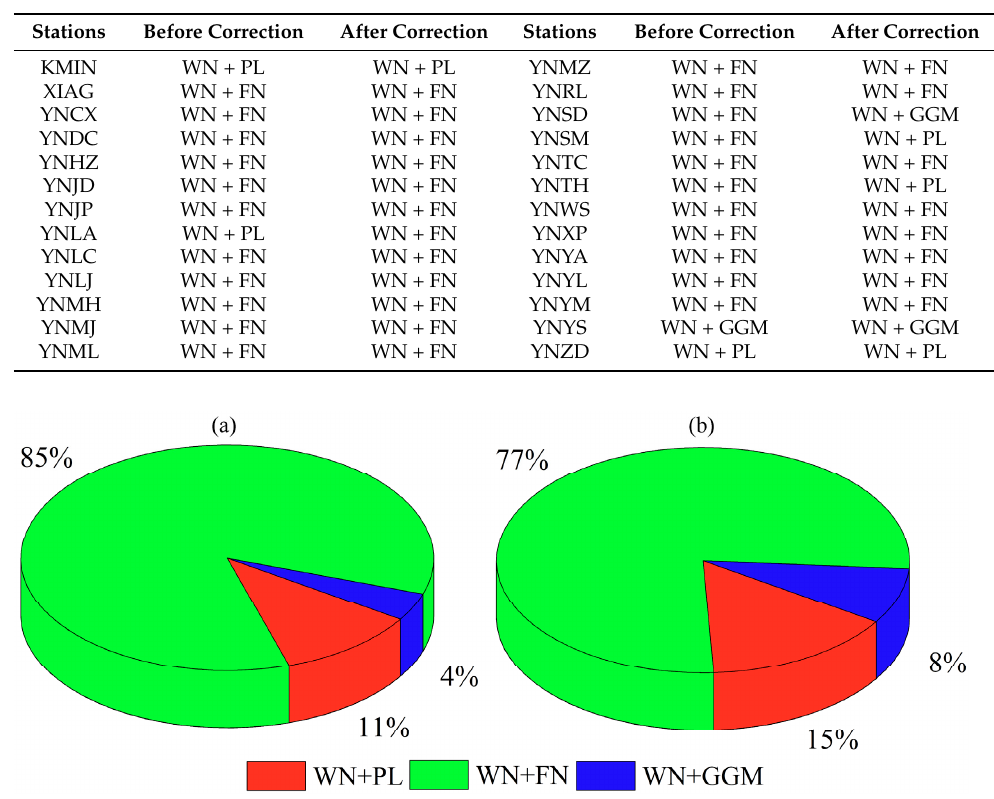
Figure 13. Optimal noise model distribution before ( a ) and after ( b ) HYDL correction.